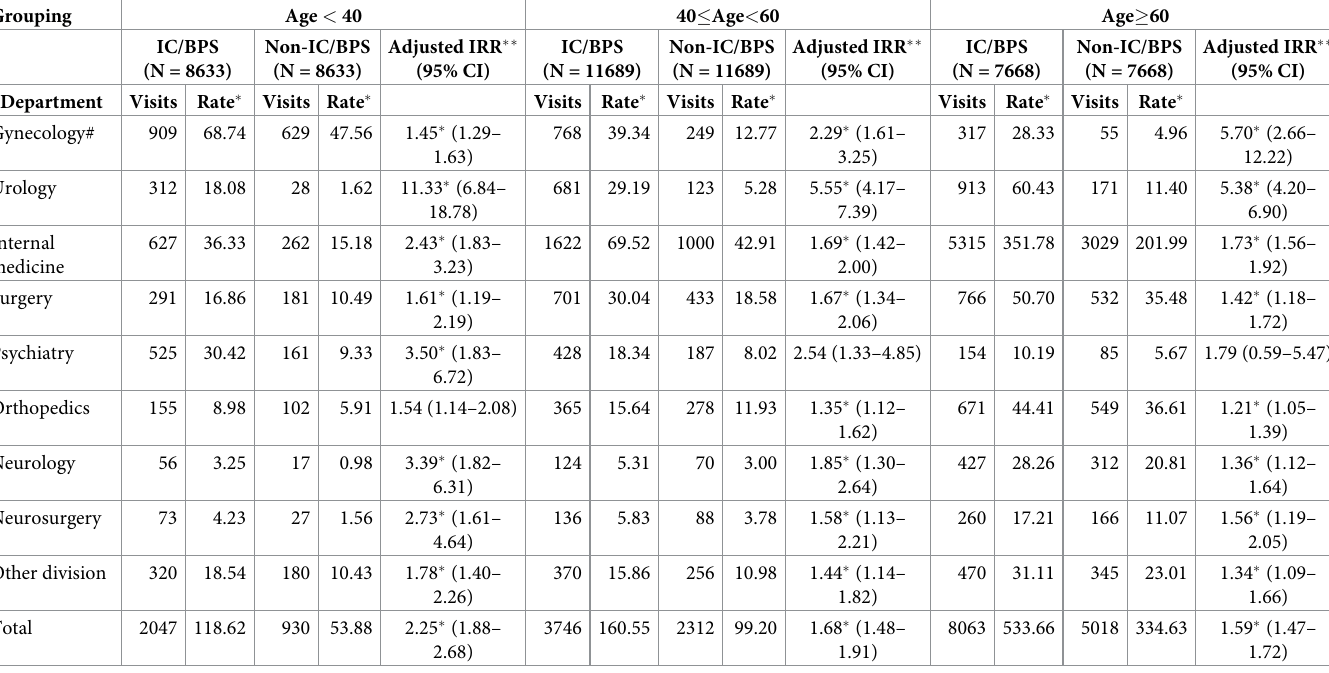
Table 5. Incidence rate ratio of hospitalizations between IC/BPS and non-IC/BPS individuals by three age